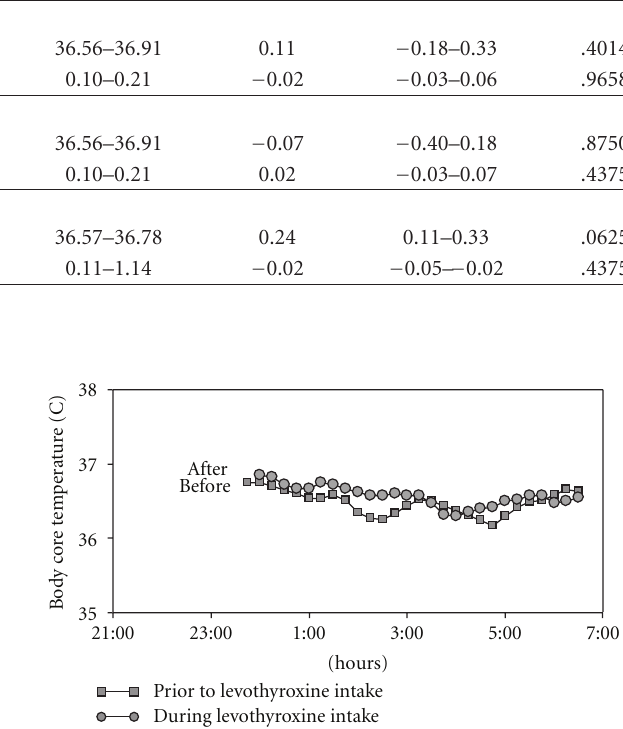
Table 3: Mean core body temperature at baseline and during maximal dosage of levothyroxine (L-T4). Temperature